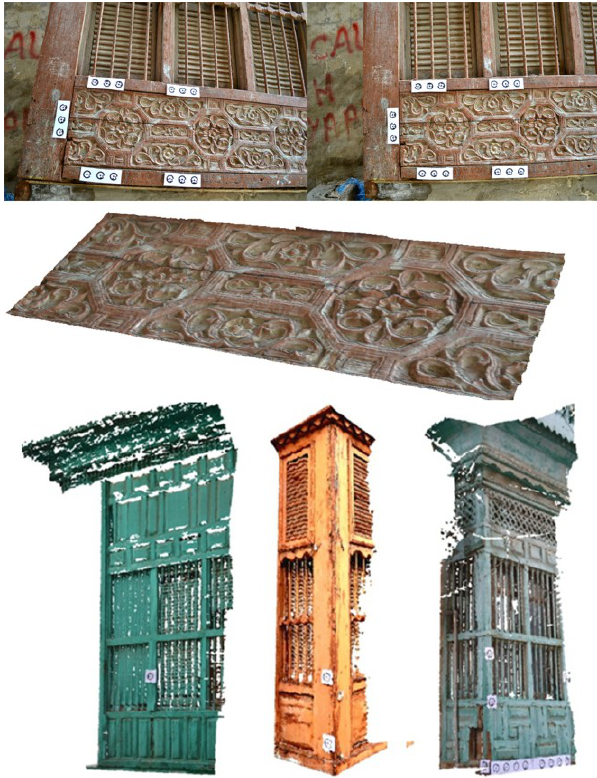
Figure 6. The results in PMS © from one and multi stereo